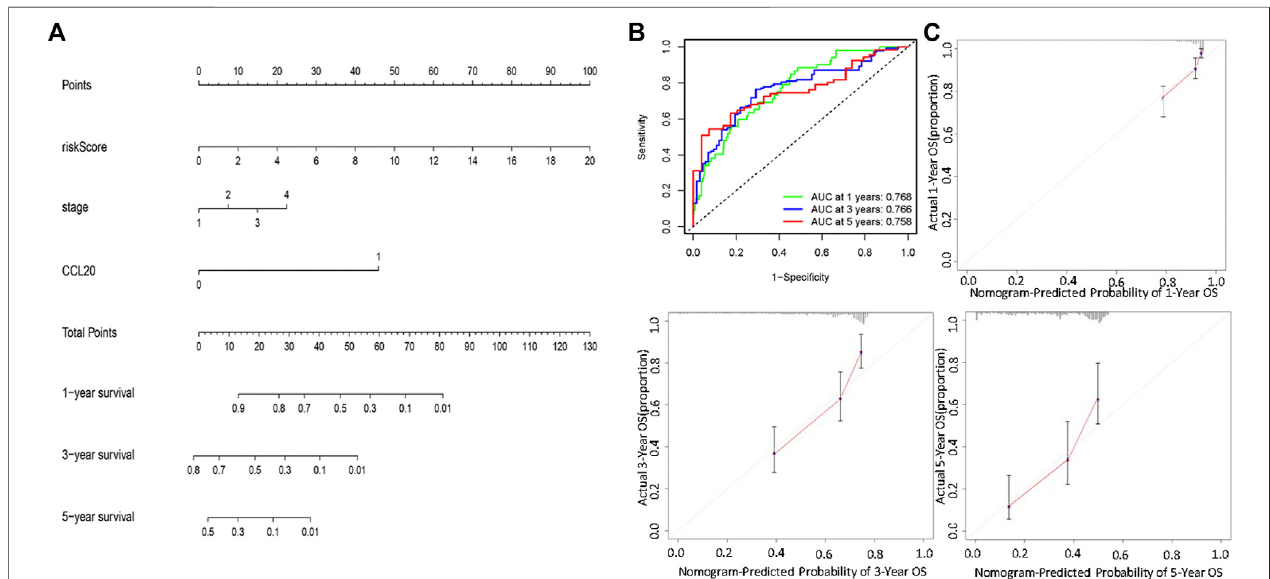
FIGURE 7 | Establishment and validation of a nomogram for predicting patient OS based on the TCGA cohort. (A) Nomogram model to predict the prognosis of LUADpatientsbasedontheTCGAcohortstage,CCL20mutationsituationandriskscorewereincludedinthepredictionmodel. (B) The1-year,3-year,and5-yearROC curve were used to assessed the prognostic performance of the nomogram. (C) The calibration curves for predicting the 1-year, 3-year, and 5-year OS.